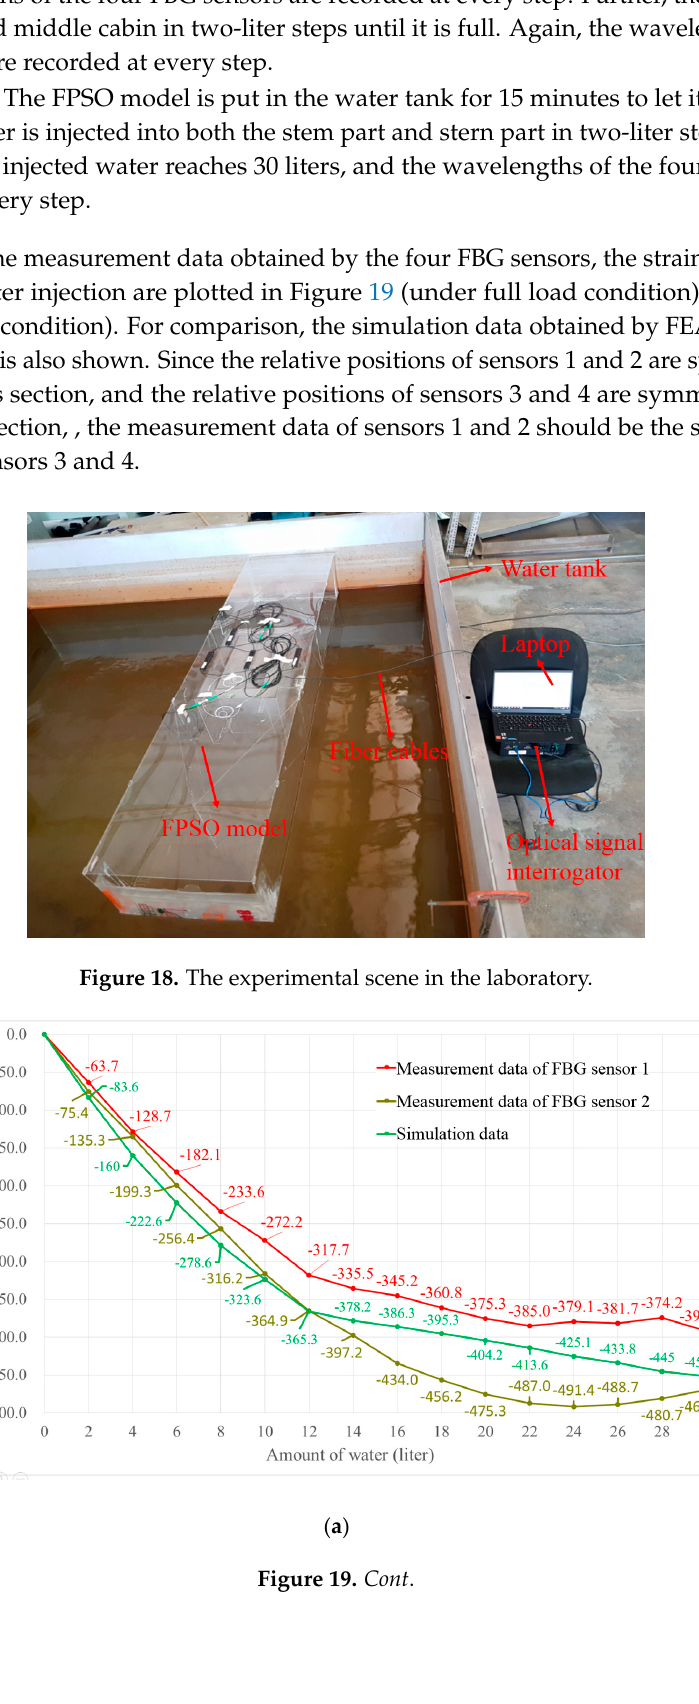
Figure 18. The experimental scene in the laboratory.